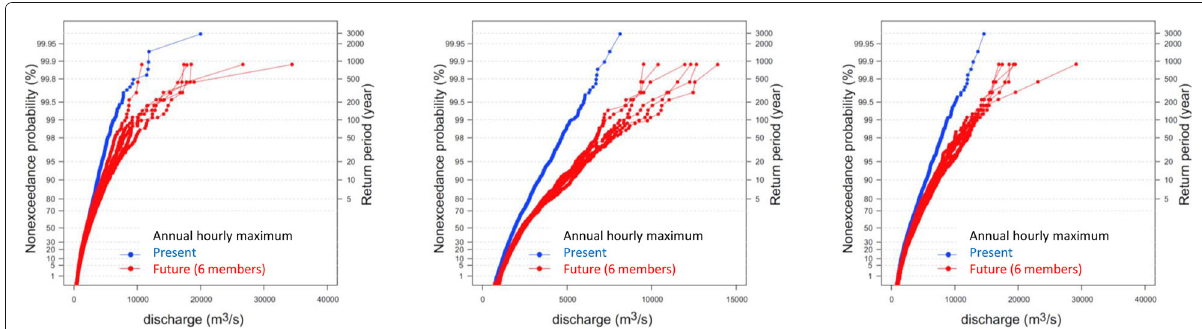
Fig. 7 Nonexceedance probabilities of river discharge for three major rivers in Japan (left: Arakawa river, middle: Shonai river, right: Yodo river; blue: past climate, red: +4 K climate) based on d4PDF-R, after Tachikawa et al. (2017)